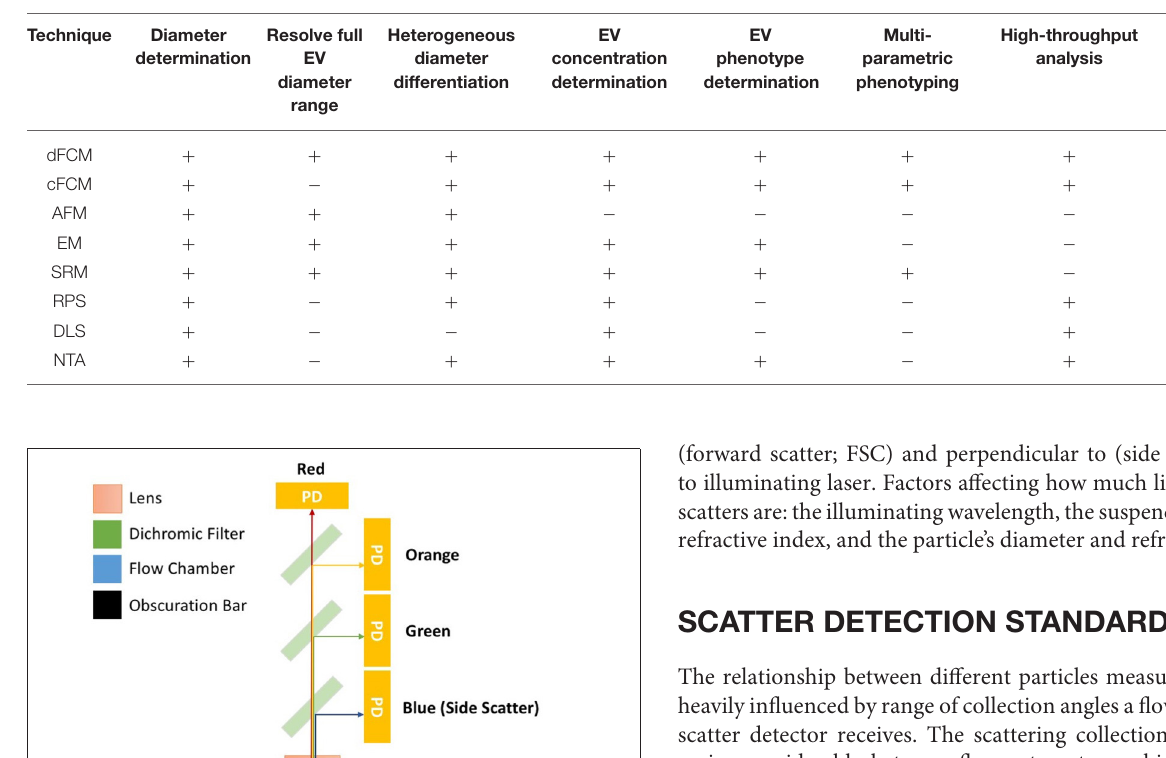
TABLE 1 | A comparison of currently utilized EV detection equipment properties.